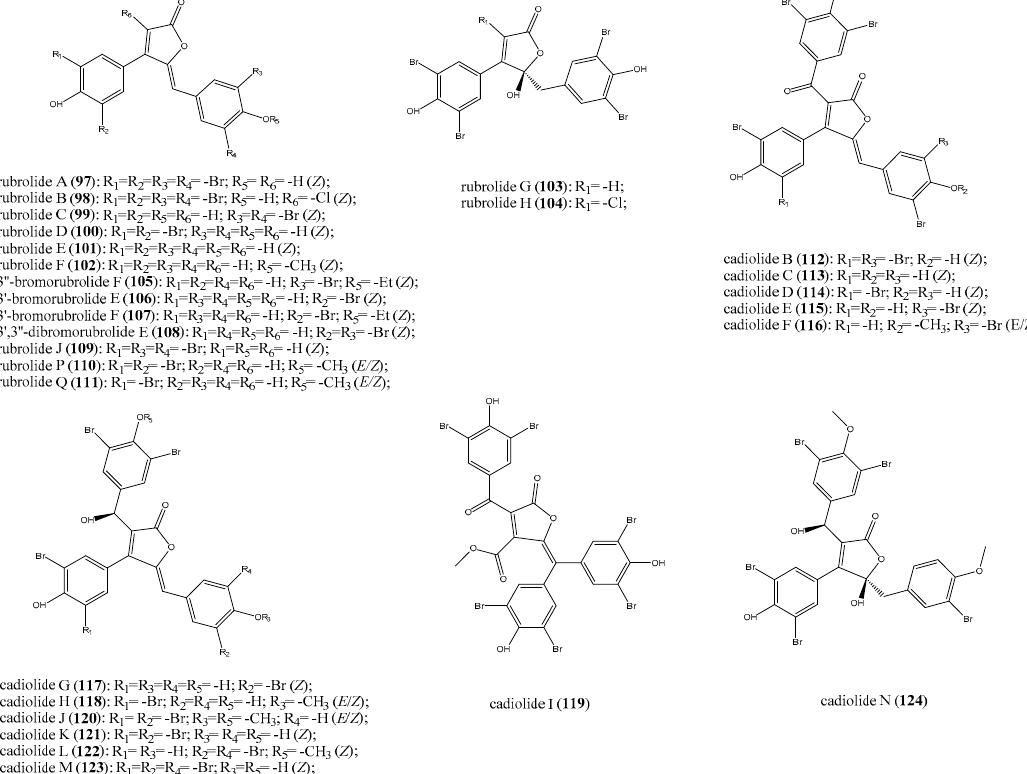
Figure 12. Structures of the furanone derivatives rubrolides A–H, J, P, and Q ( 97 – 111 ) and cadiolides B–N ( 112 – 124 ).